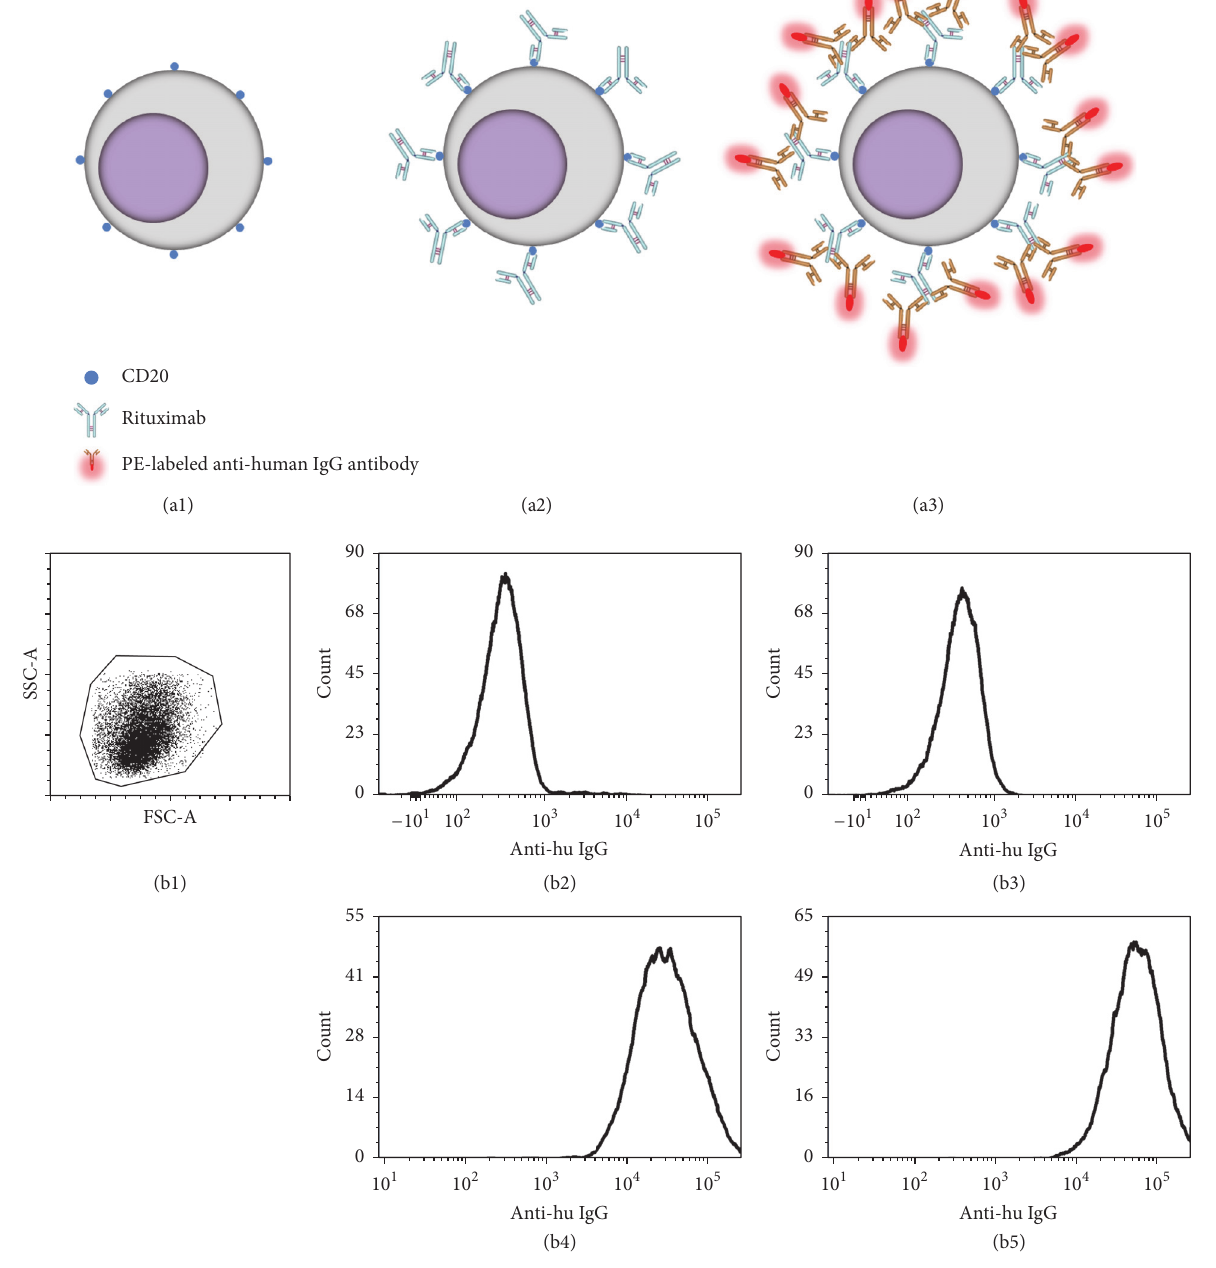
Figure 2: CD20 expressing Daudi cells (a1) were incubated with urine for 20min to enable suspected Rituximab to bind the CD20 antigen (a2). After three washes in PBS/BSA, cells were incubated with a PE-labeled anti-human IgG antibody and incubated for 20 min (a3). After three washes in PBS/BSA, cells were subjected to flow cytometry analysis. Controls were identically performed but by using Octagam solution instead of urine. Flow cytometric analysis of Daudi cells. Daudi cells were gated according to their FSC/SSC properties (b1). Histograms of Daudi after incubation with PBS (b2), Octagam (b3), urine of the first patient (b4), and peritoneal dialysate fluid of the second patient (b5) are shown. Cell numbers are shown on 𝑦 -axis and relative fluorescence intensity of the secondary (anti-human IgG) antibody on 𝑥 -axis.